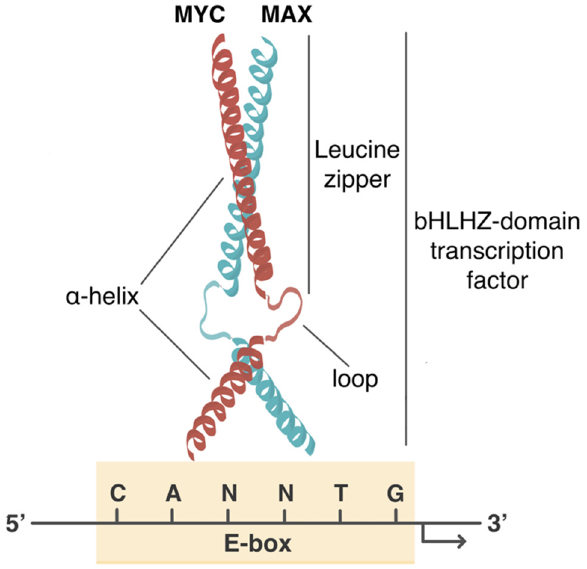
Figure 1. Molecular interactions of MYC: dimerization with MAX and DNA binding. MYC is a basic helix-loop-helix leucine-zipper (bHLHZ) transcription factor. The helix-loop-helix domain allows DNA binding, whereas leucine zipper allows the MYC–MAX interaction. MYC transcription factor requires dimerization with MAX to recognize and bind to specific DNA CANNTG sequences (where N can be any nucleotide), termed E-box.